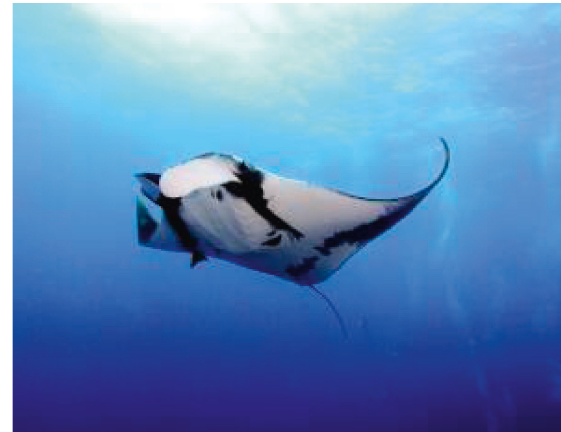
Figure 7: A foraging manta ray.